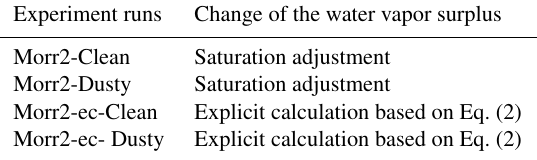
Table 2. Cases to investigate the influences of the saturation adjust- ment on the dust–cloud interaction based on the settings of Morr2- Clean and Dusty. The saturation adjustment assumption is replaced by the explicit calculation of the water vapor surplus/condensation (Morr2-ec-Clean and